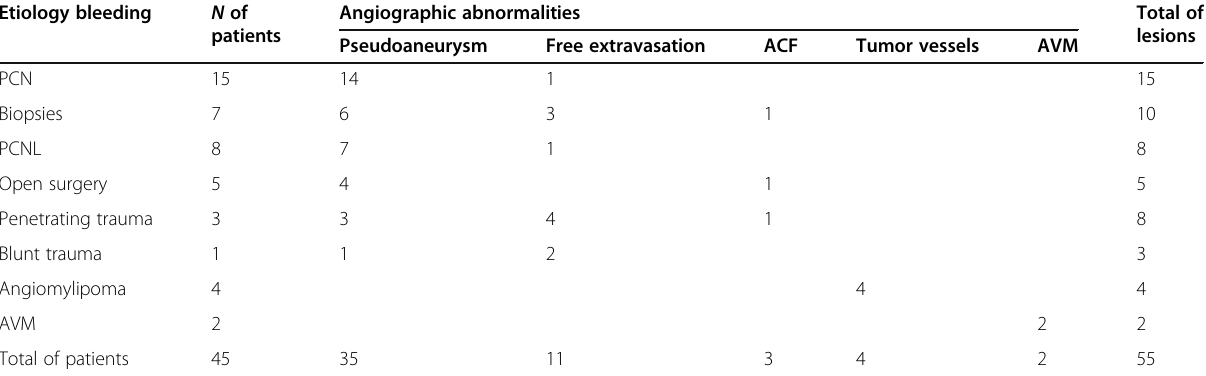
Table 1 Causes of acute renal bleeding and the number of lesions with different abnormalities on renal arteriography Etiology bleeding N of patients